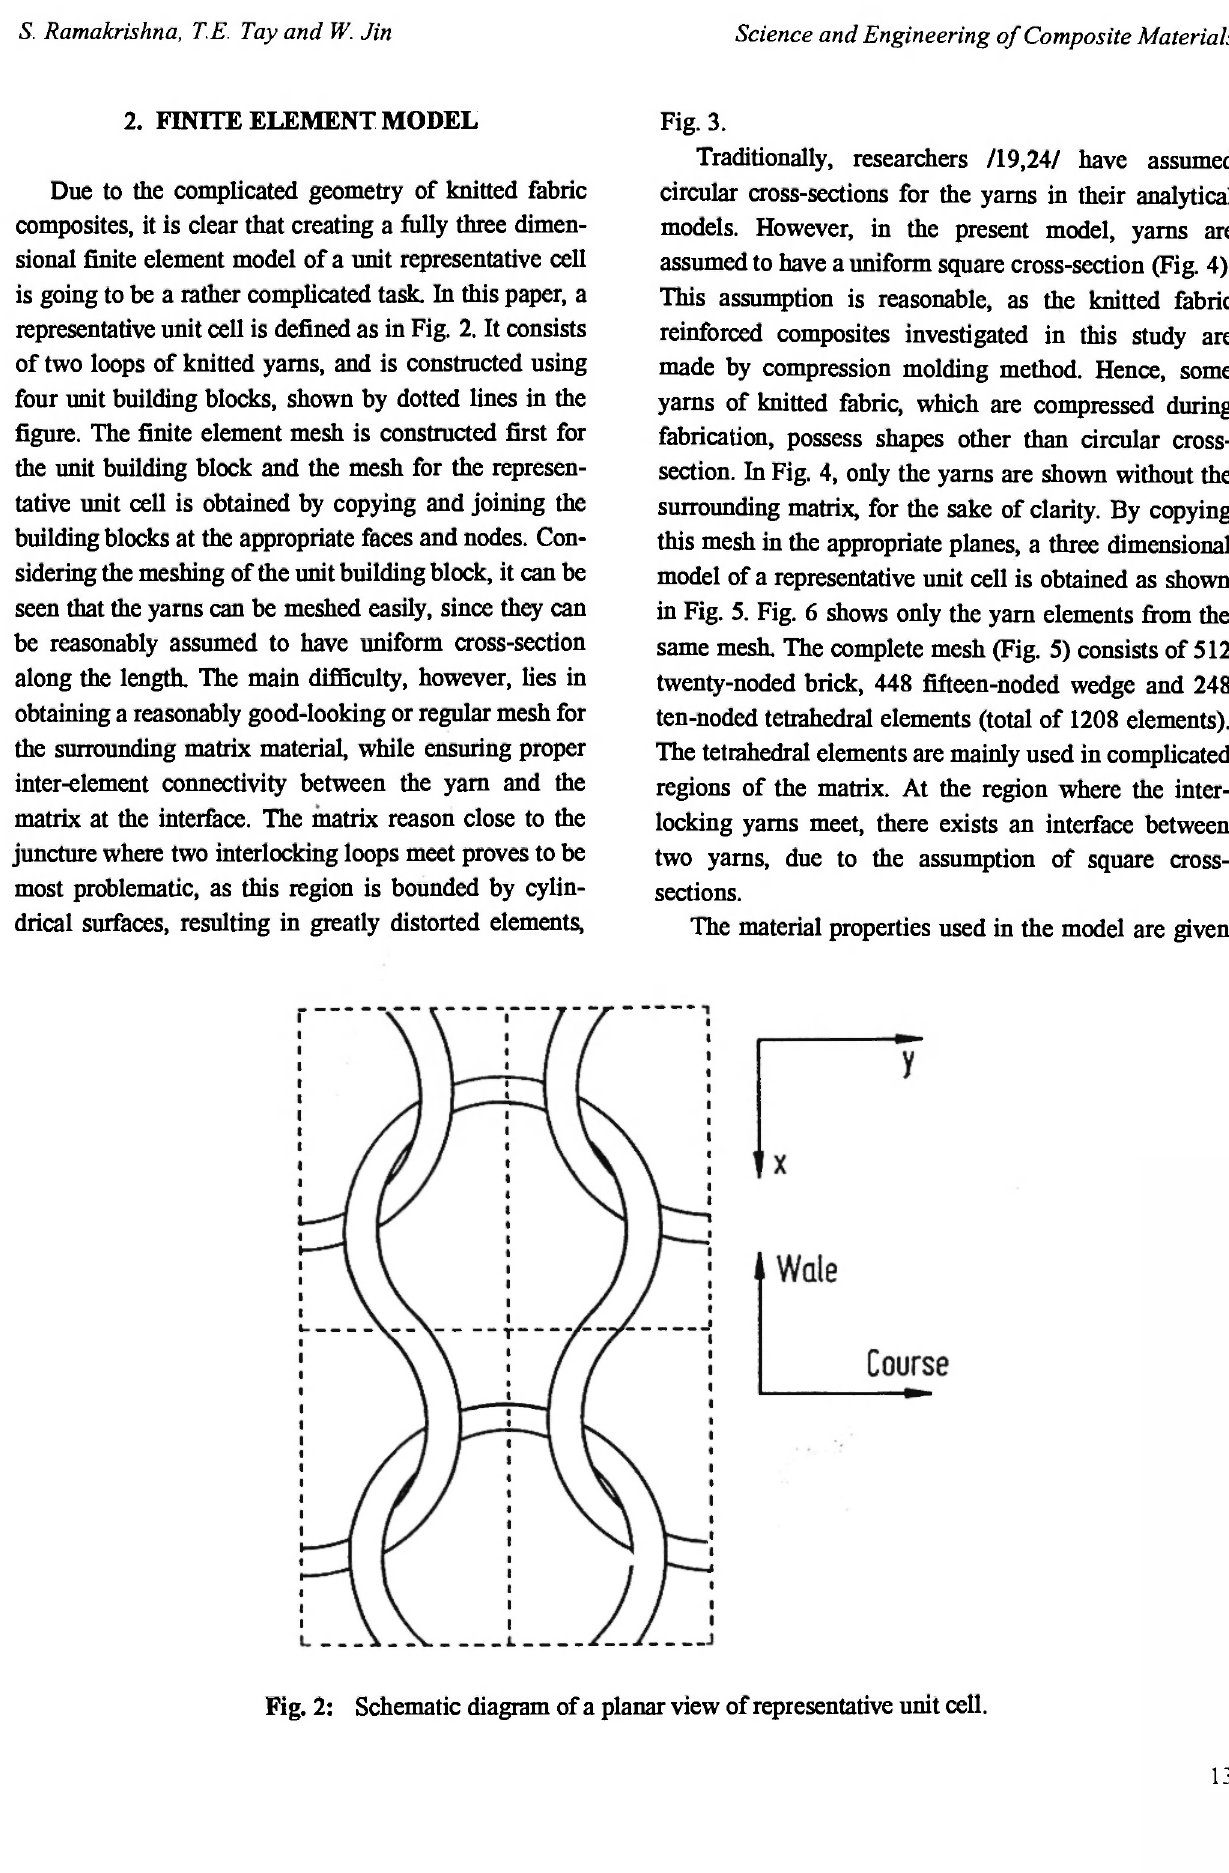
Fig. 2: Schematic diagram of a planar view of representative unit